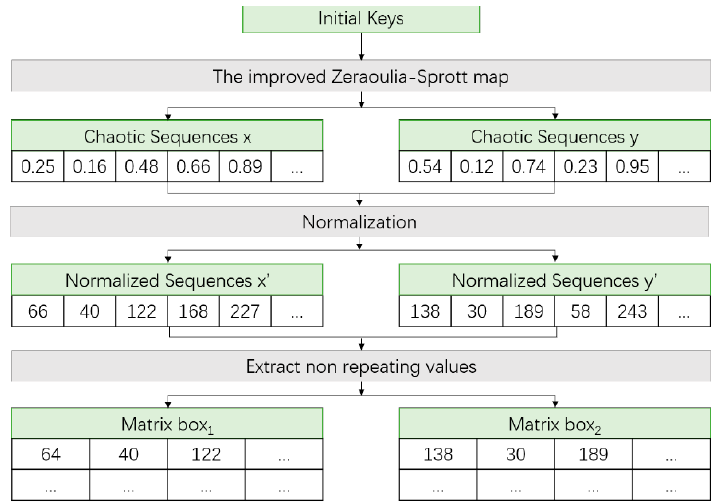
Figure 2. The construction of the S-Box.